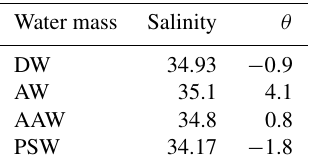
Table 2. Water mass endmember definitions for mixing calcula- tions. Water mass acronyms as in Table 1, θ is potential tempera- ture.